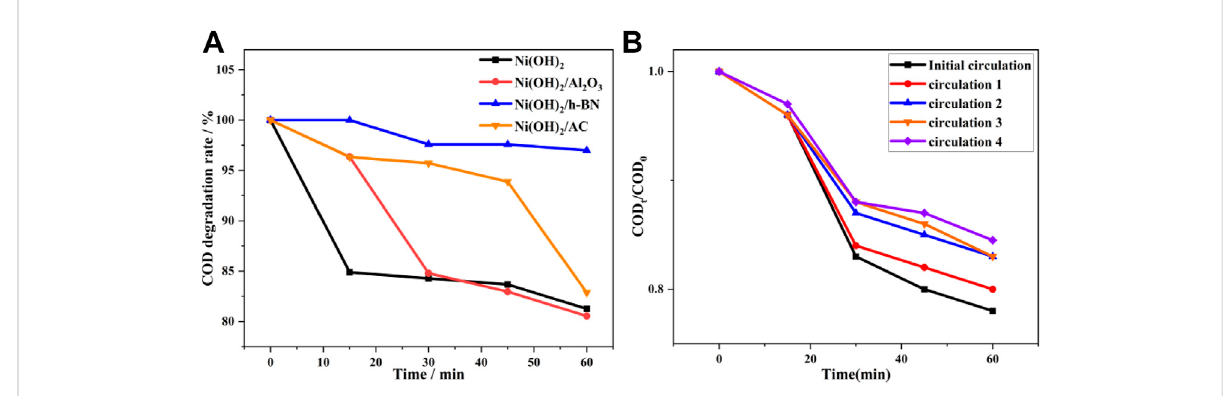
FIGURE 10 (A) Comparison of the performances of four photocatalysts for the degradation of fracturing fl owback fl uid; and (B) Cycling runs in the photocatalytic degradation of α -Ni(OH)